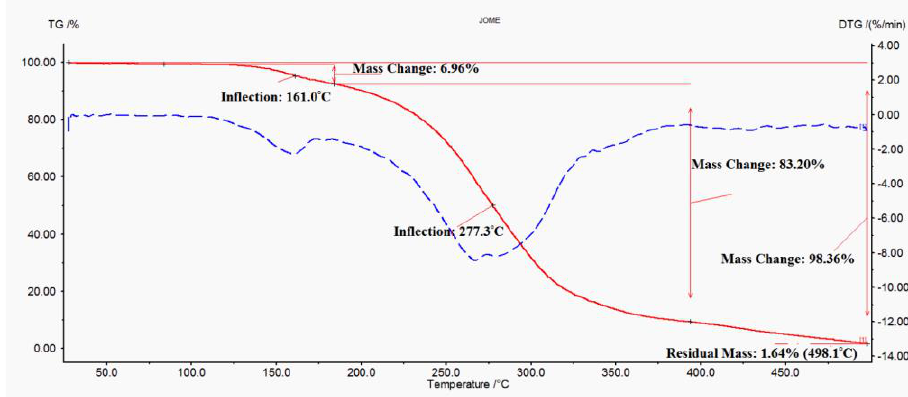
Figure 4. TG-DTG curve for JOME.